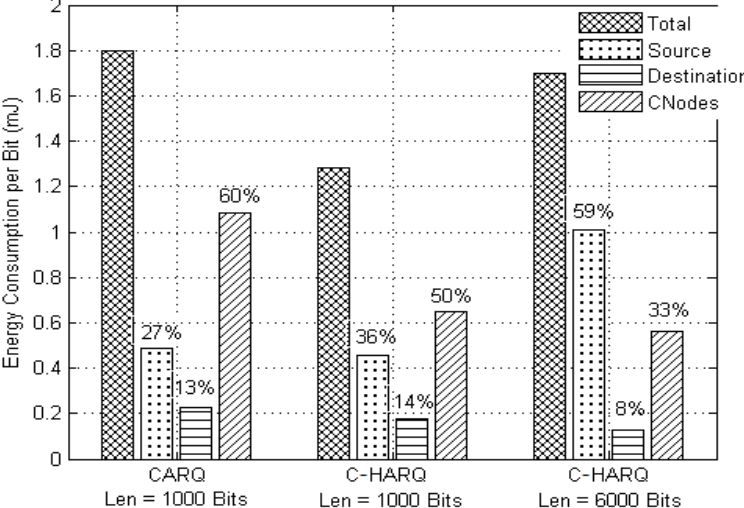
Figure 7. Average Energy consumption per bit (in mJ) at various nodes for CARQ and C-HARQ protocols, with nCN =